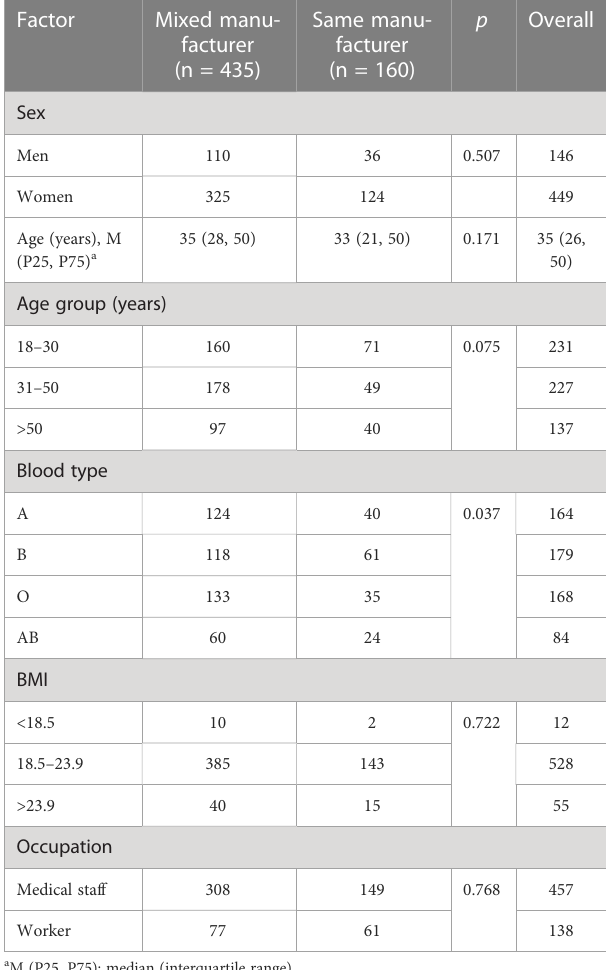
Participants with blood type A and workers had lower levels of